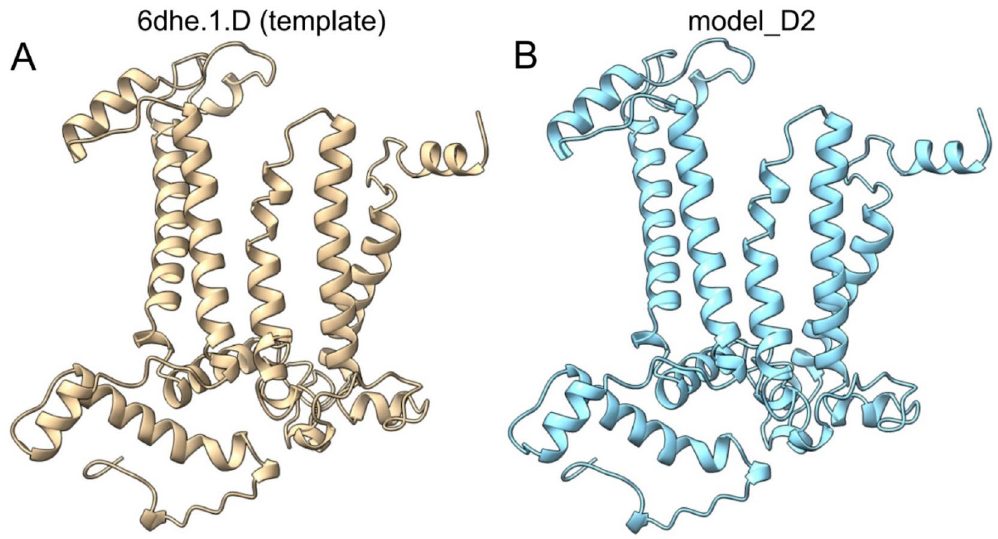
Figure 3. The predicted 3D structure of the ancestral D2 protein. ( A ) The structure of the template sequence from T. elongatus (PDB 6dhe.1.D). ( B ) The structure of the predicted D2 protein (model_D2). The 3D protein structures were visualised and analysed using UCSF ChimeraX software 31